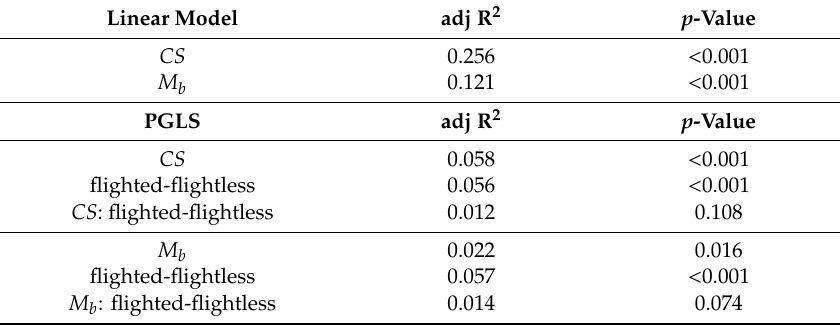
Table 2. Summary of multivariate regressions for allometric variation of humeral shape based on Procrustes coordinates ( Pcoor ) on body mass ( M b ) and centroid size ( CS ). Linear Model adj R 2 p -Value CS 0.256 < 0.001